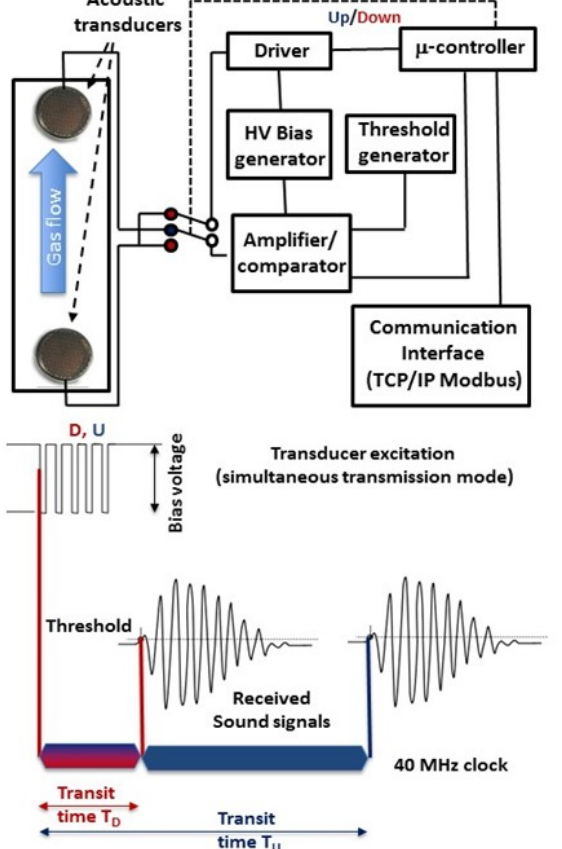
Figure 2. Electronics for ultrasonic transducer excitation and bi-directional transit time measure- ment.